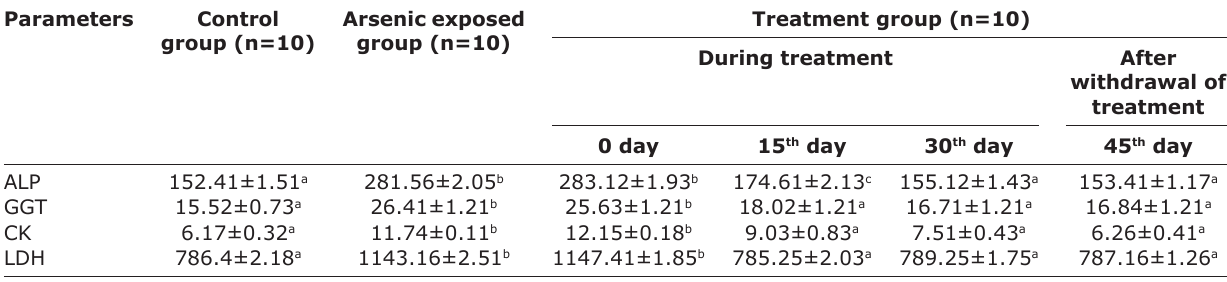
Table-3: Liver and muscle function enzymes (U/L) (mean±SE) in control, arsenic exposed and Terminalia arjuna bark powder treated buffaloes.